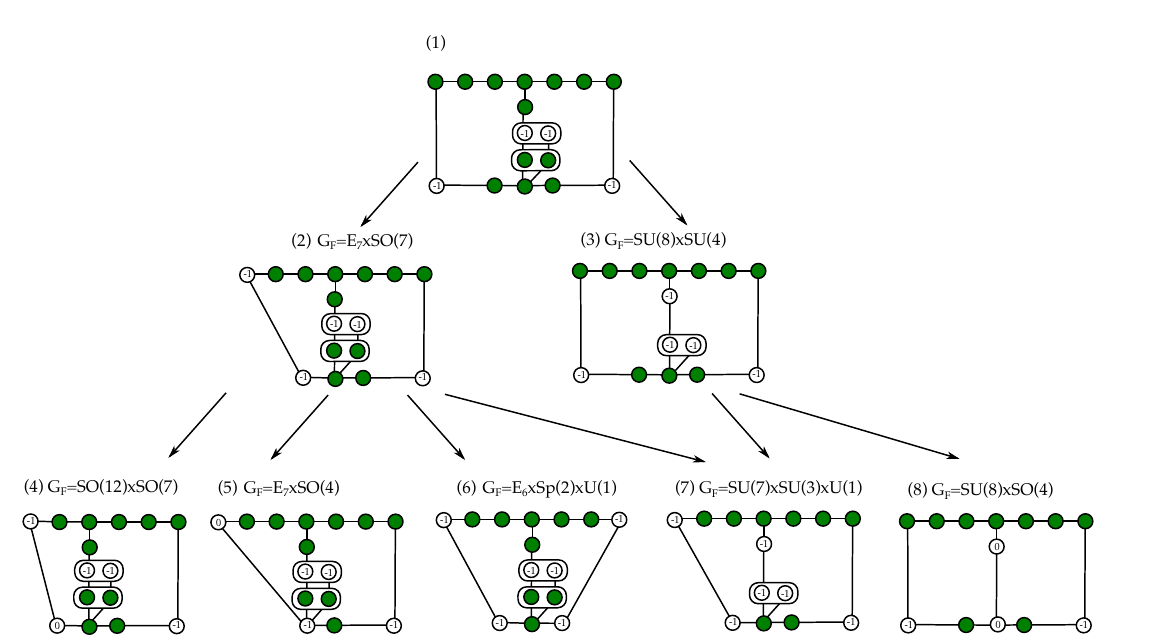
Figure 24. ( E 7 ; SO(7)): the (cid:12)gure shows the (cid:12)rst few descendants of the marginal CFD (5.13) for the ( E 7 ; SO(7)) theory, including the enhanced superconformal (cid:13)avor symmetries G F .